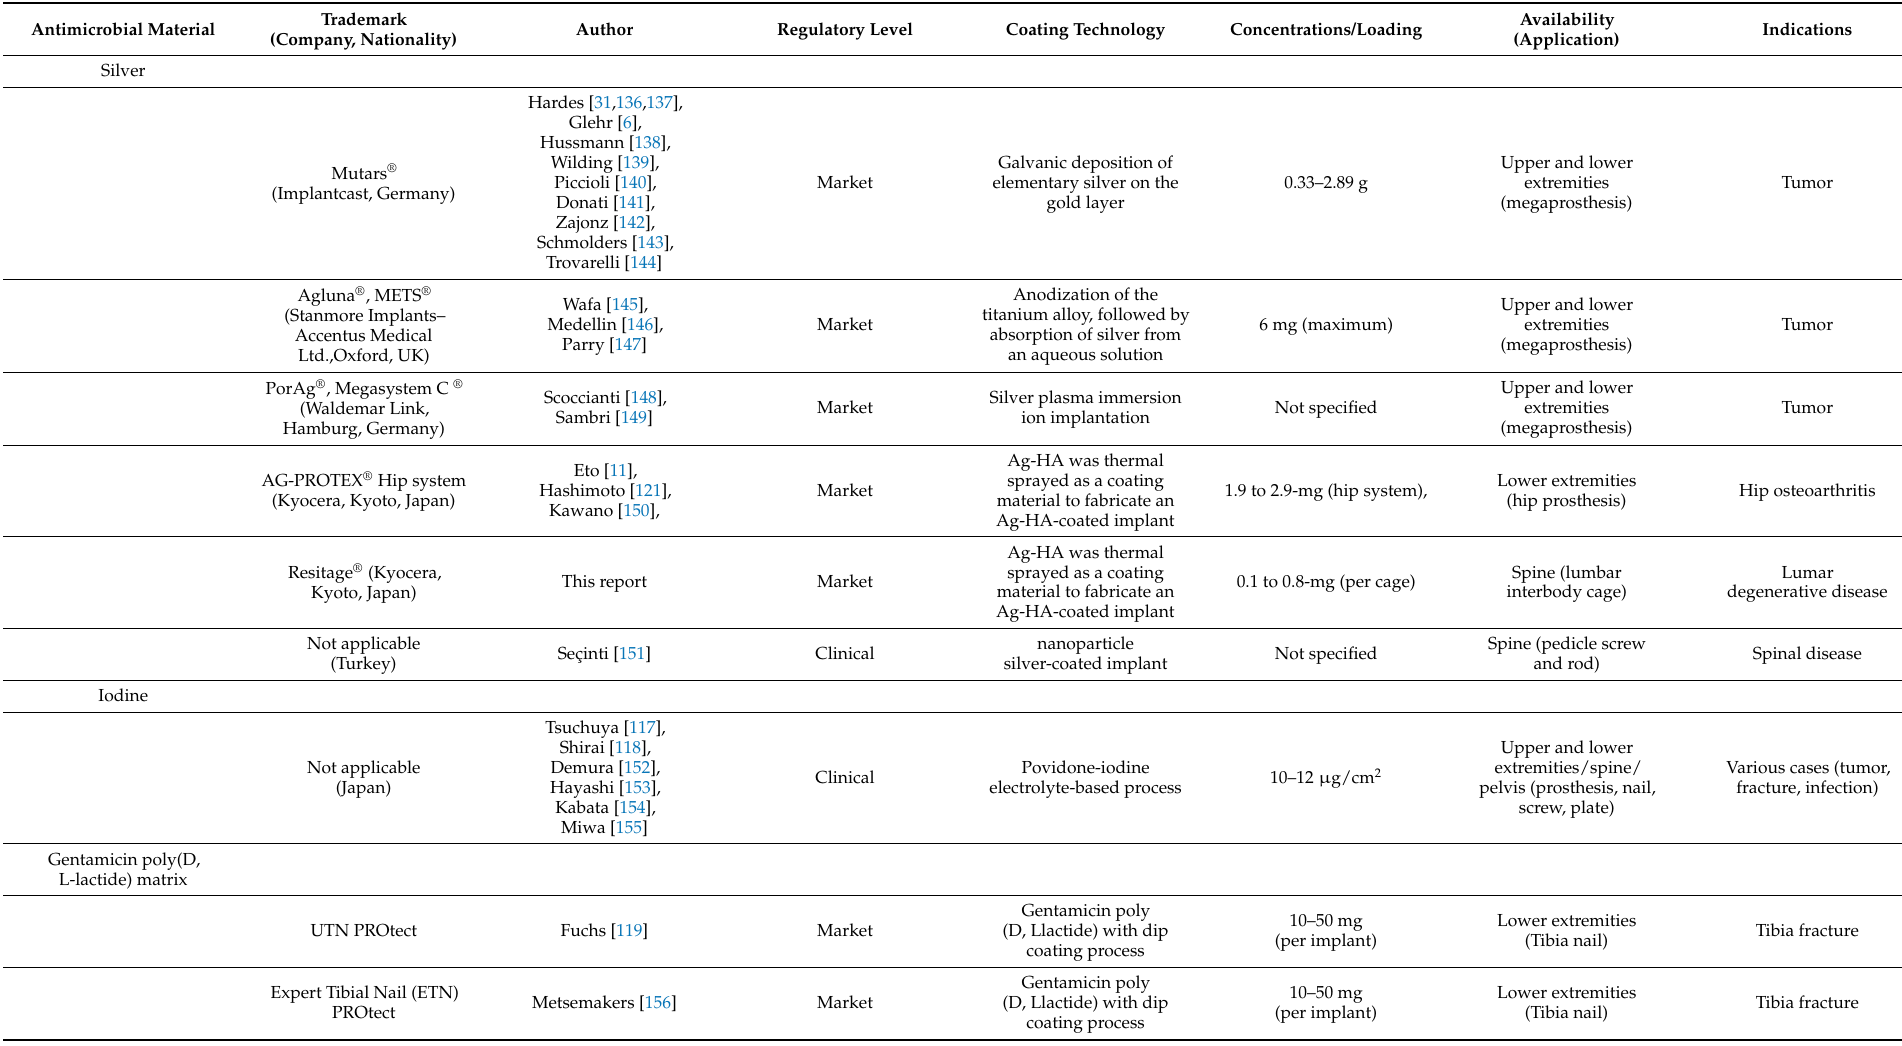
Table 2. Antimicrobial implants for clinical use in orthopedic and spinal